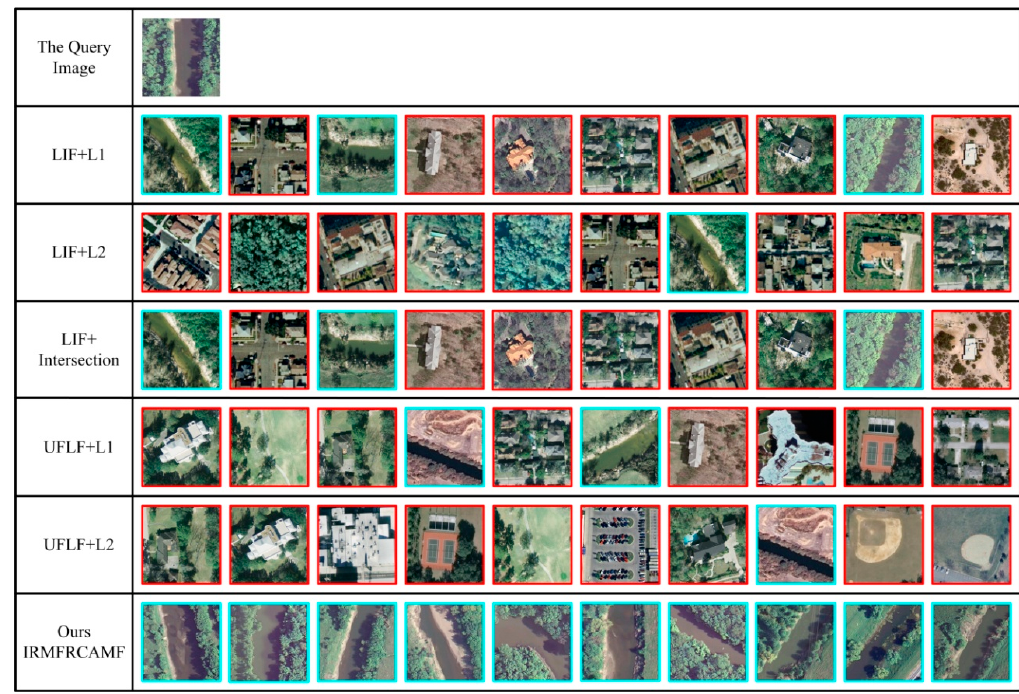
Figure 9. Visual illustration of the retrieved images using different methods when the query image comes from the river class. The red rectangles indicate incorrect retrieval results, and the blue rectangles indicate correct retrieval results.